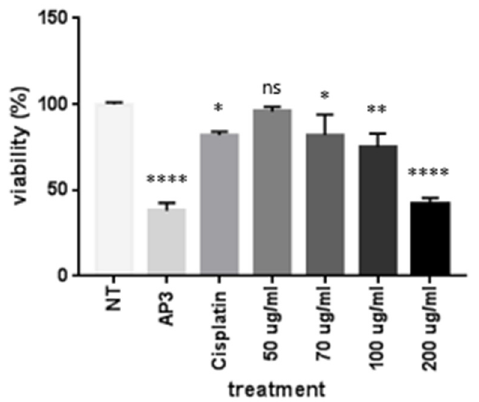
Figure 1. The ethanolic extract of Ocimum sanctum Linn. (EEOS) inhibited the adhesion of A549 cells (non-small cell lung carcinoma). The cells were cultivated in the presence of an inhibitor (AP3) as the positive control, cisplatin as the commercial drug comparison, and EEOS at concentrations of 50, 70, 100, and 200 µg/mL. After 24 h, EEOS’s inhibitory effect was visualized using MTT reagent at a wavelength of 450 nm (NT: non-treated; * significant p = 0.0332; ** significant p = 0.026; **** significant p < 0.0001; n.s. = not significant).